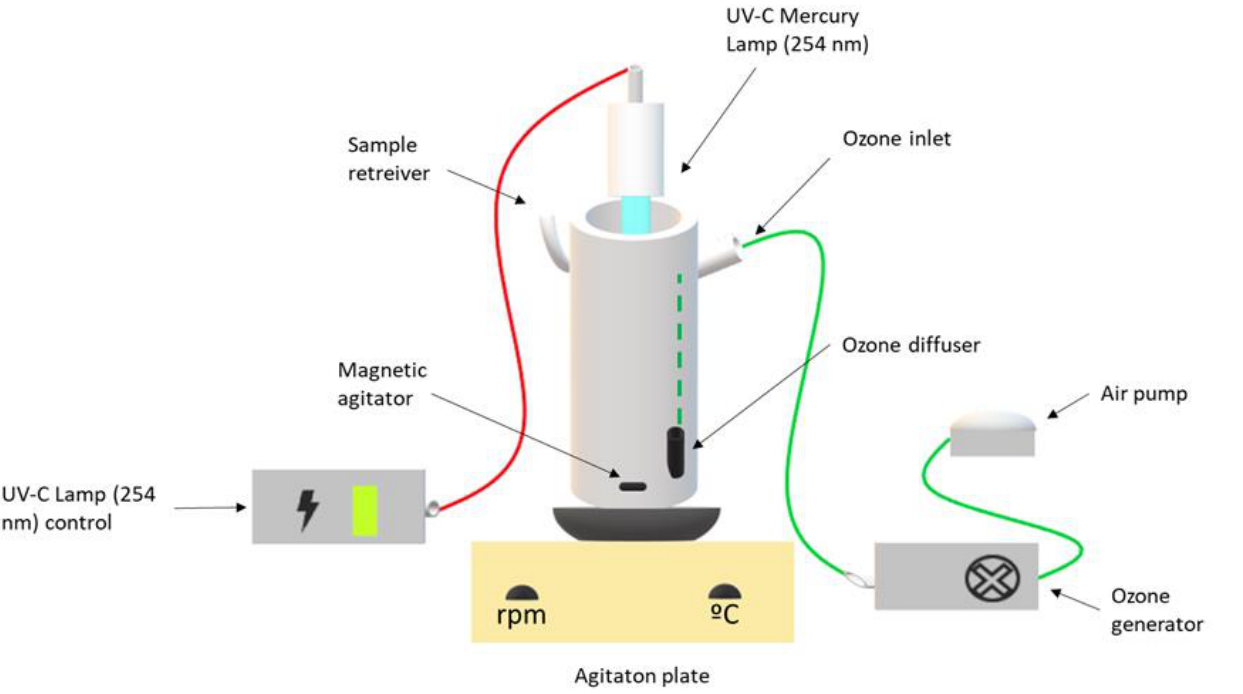
Figure 2. Schematic representation of ozonation and UV reactor. The photoreactor was fitted with a Heraeus TNN 15/32 lamp (14.5 cm in length and 2.5 cm in diameter), mounted in the axial position inside the reactor. The spectral output of the low-pressure mercury vapor lamp emitted mainly (85–90%) at 253.7 nm and about 7–10% at 184.9 nm. The experiments were carried out as